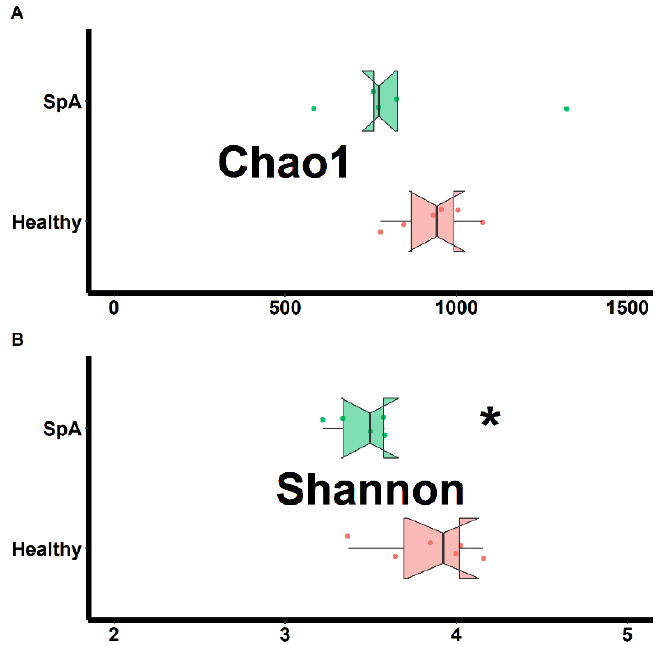
Figure 2. Assessment of richness (chao1; Figure 2A) and evenness (Shannon; Figure 2B) obtained from the saliva of patients with Spondyloarthritis (SpA) and healthy controls. * indicates statistically significant at p < 0.05.